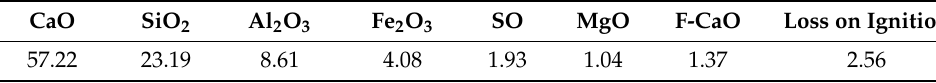
Table 4. Chemical composition of ordinary Portland